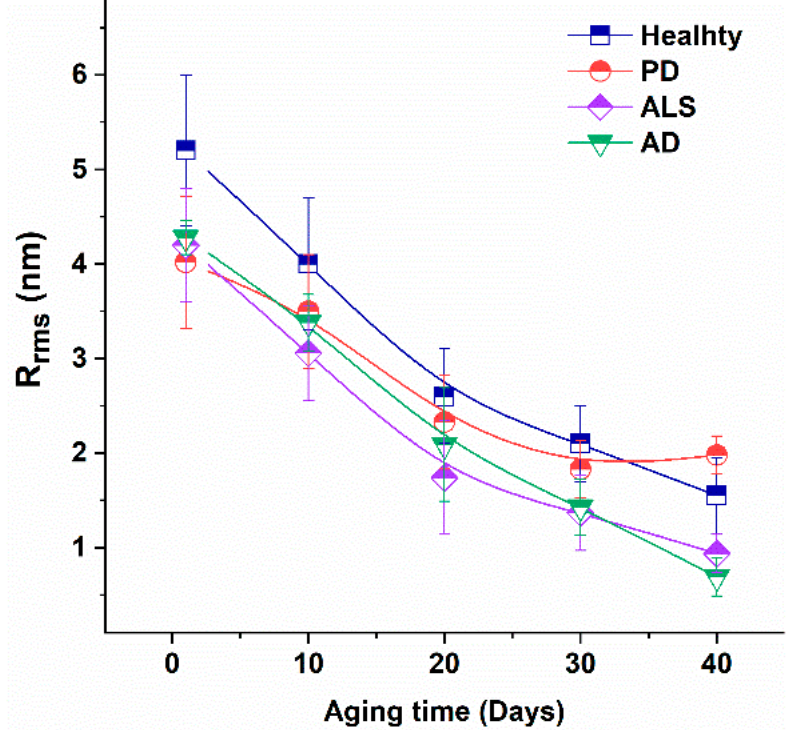
Figure 5. Surface roughness (R rms ) of healthy, PD, ALS and AD cells vs aging time. Mean values and SD. Table 1. Morphological parameters—diameter (D), height (H) and volume (V) of biconcave, crenate, spiculated and spherocytic shapes of RBCs from healthy subjects and NDDs patients. Mean values and SD.